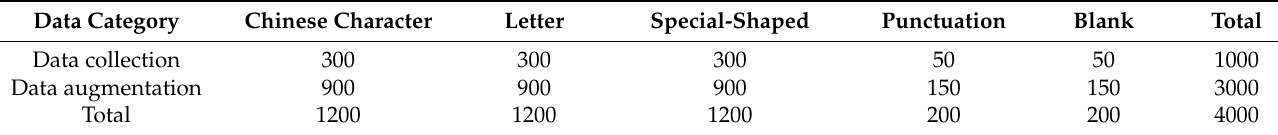
Table 1. Quantity details of wooden block image datasets.